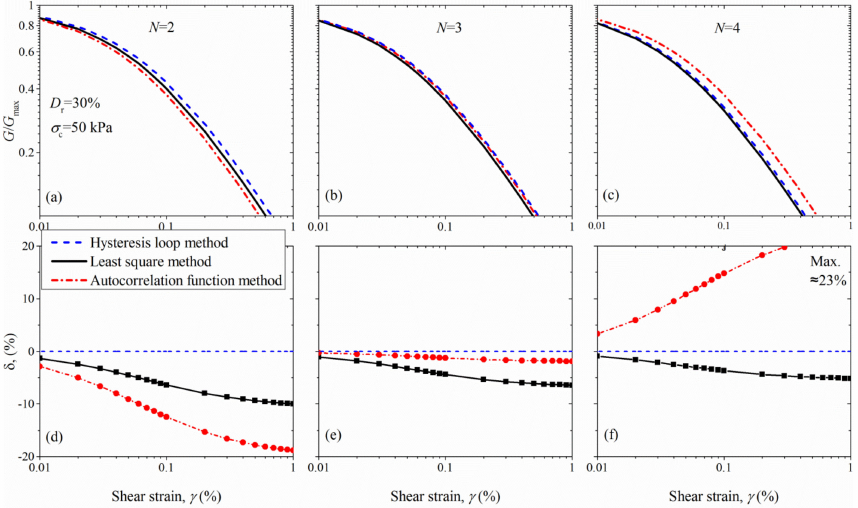
Figure 16. G / G max curves of two determination methods for N = 2, 3, 4 and the corresponding percentage